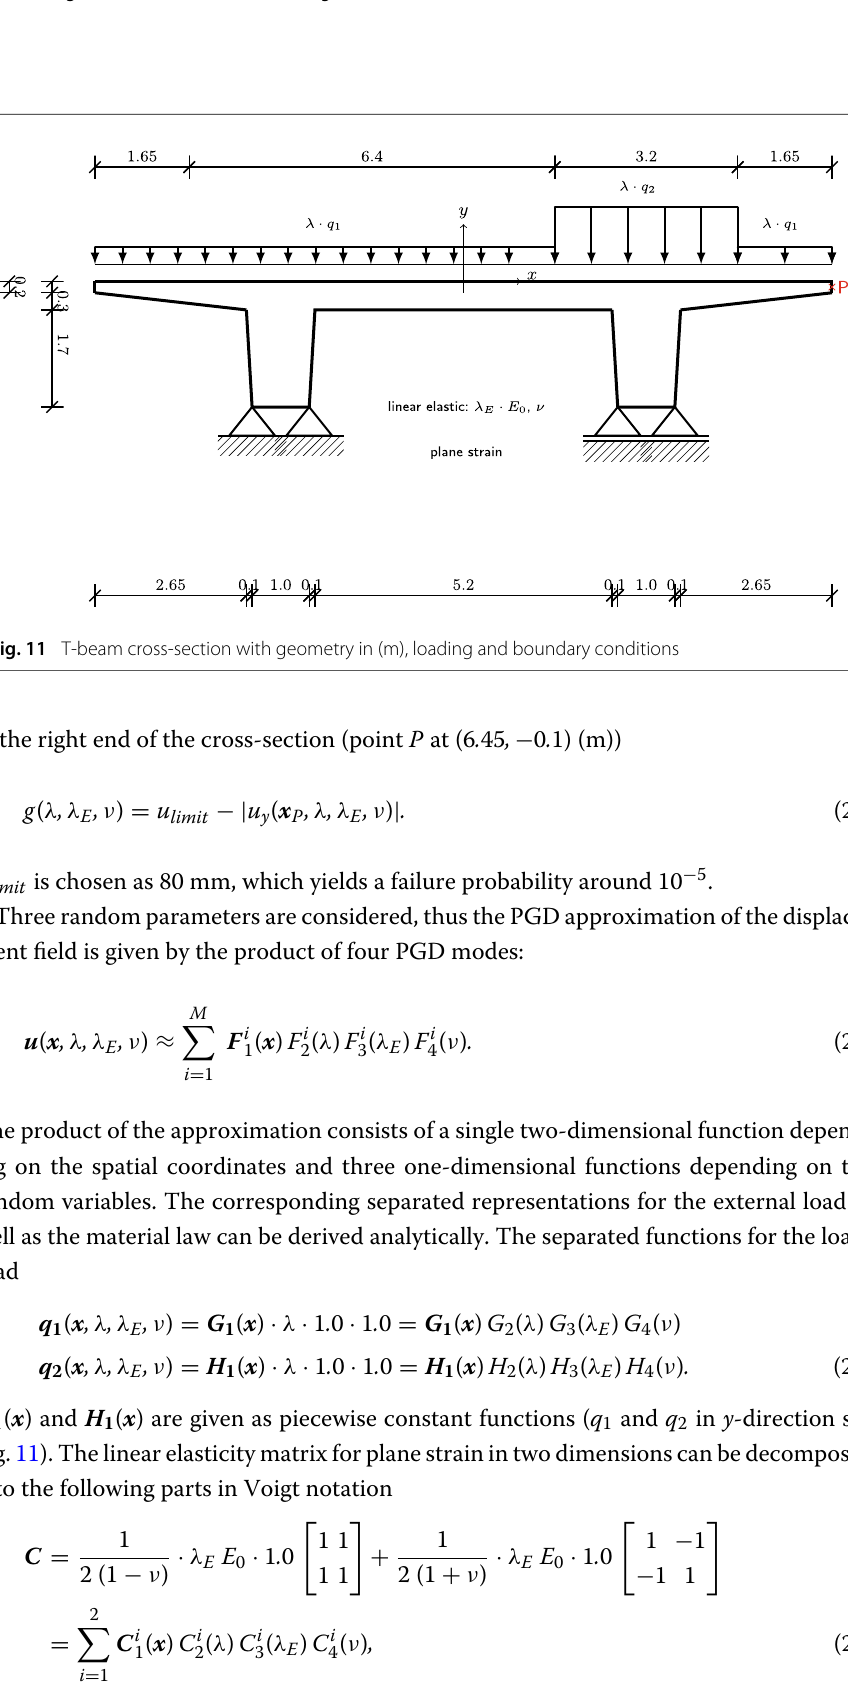
Fig. 11 T-beam cross-section with geometry in (m), loading and boundary conditions